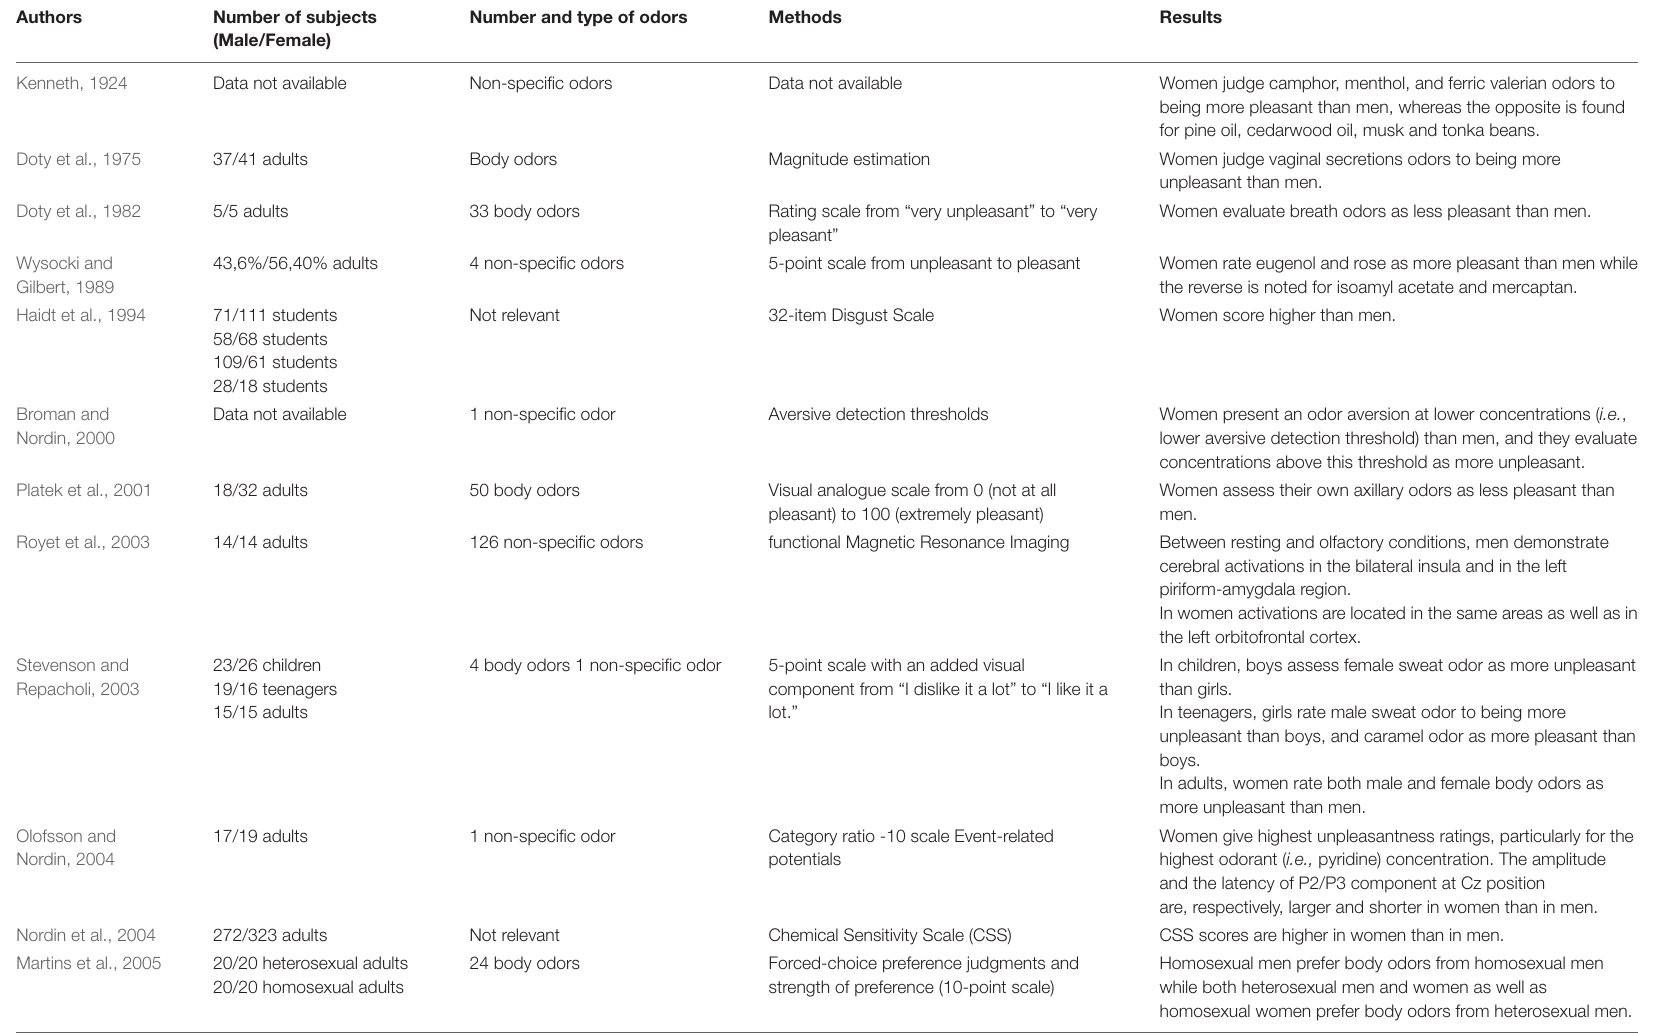
TABLE 1 | Summary of studies in healthy populations showing sex differences in odor hedonic perception (non-specific odors and body